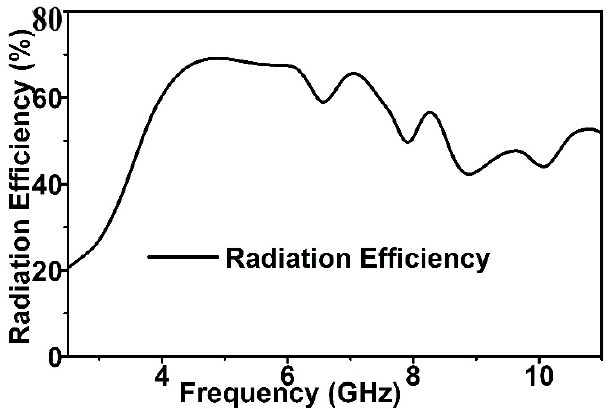
Figure 14. Radiation efficiency of the proposed MTM antenna with the breast model.